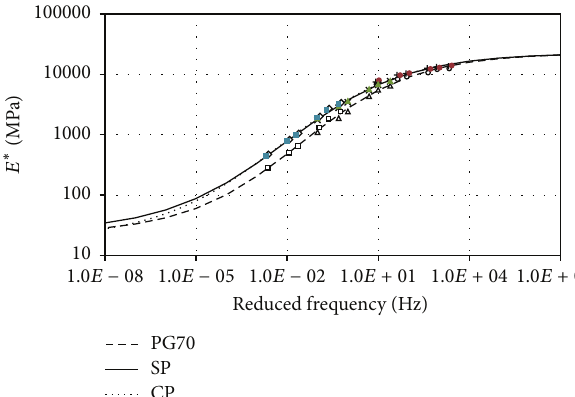
Figure 4: 𝐸 ∗ master curve at reference temperature of 21 ∘ C.